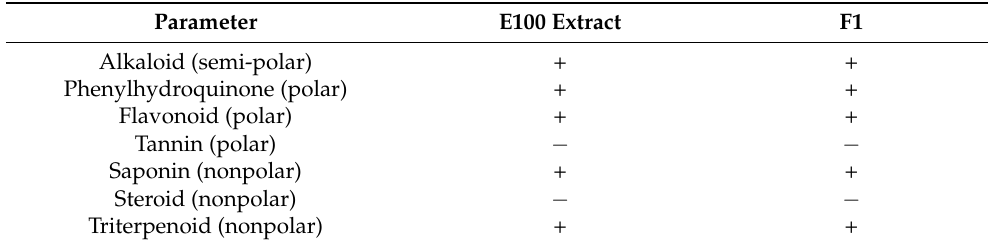
Table 5. Qualitative phytochemical constituent of D. acehensis resin E100 and its phytosome. Parameter E100 Extract F1 Alkaloid (semi-polar) + + Phenylhydroquinone (polar) + + Flavonoid (polar)